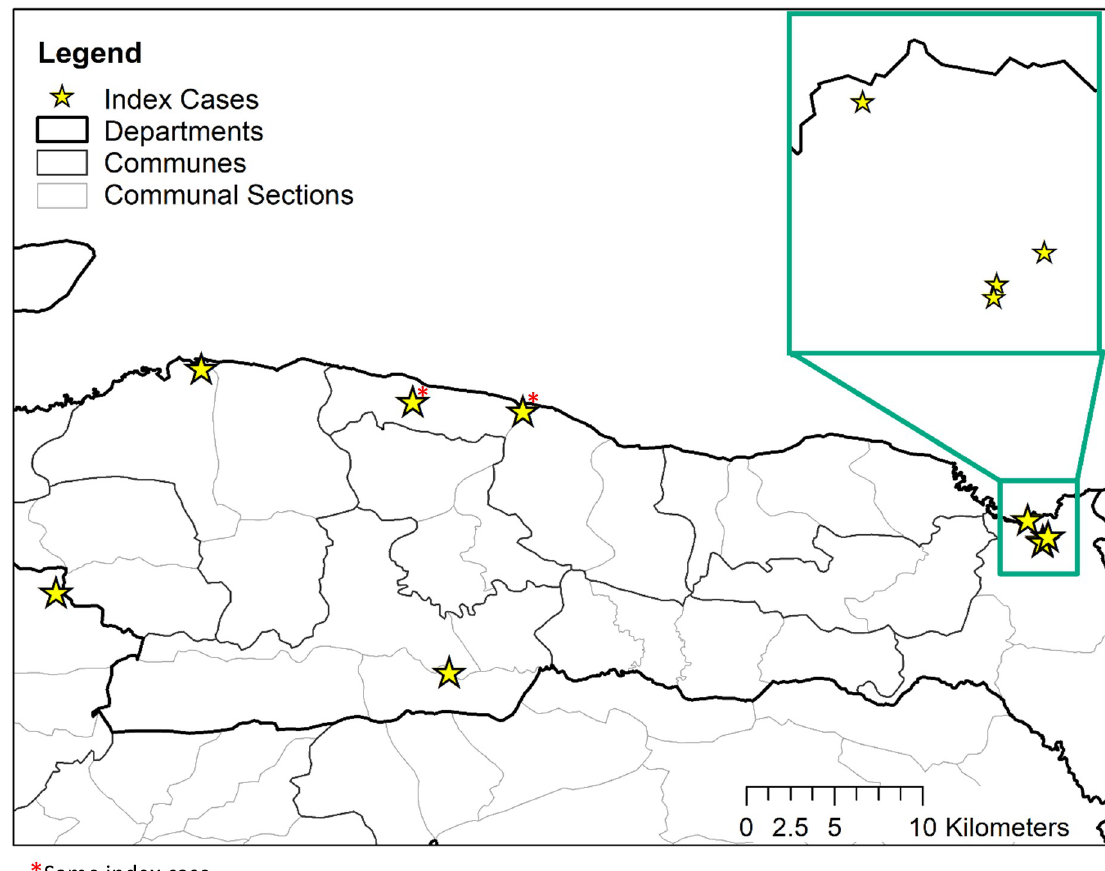
Fig 1. Locations of antigen-positive lymphatic filariasis cases identified in TAS 2, Nippes Department, Haiti 2017. Exact locations are jittered for participant confidentiality. Shapefiles for administrative boundaries are from the Centre National d’Information Geo-Spatiale and are available at https://data.humdata.org/dataset/hti-polbndl-adm1-cnigs-zip.